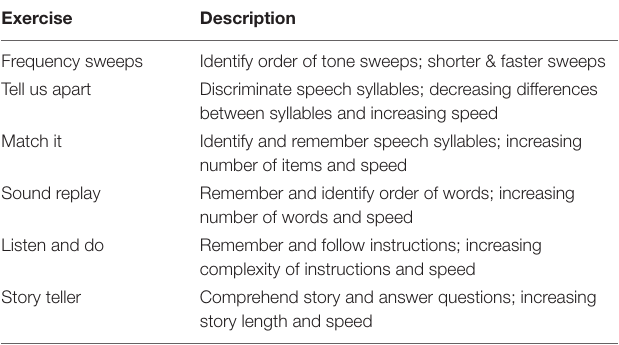
TABLE 2 | Brain fitness